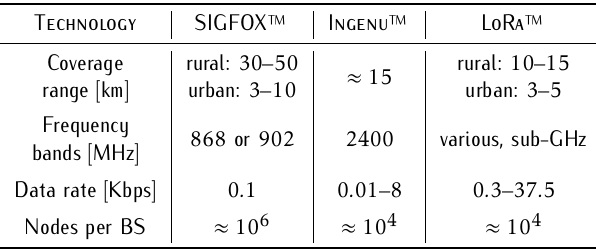
Table 1. Comparison among LPWAN radio